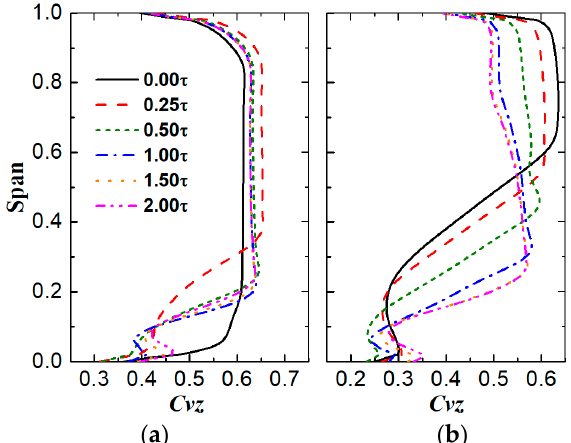
Figure 13. Circumferentially averaged normalized axial velocity of stator outlet. ( a ) In the DE condition; ( b ) in the NS condition.